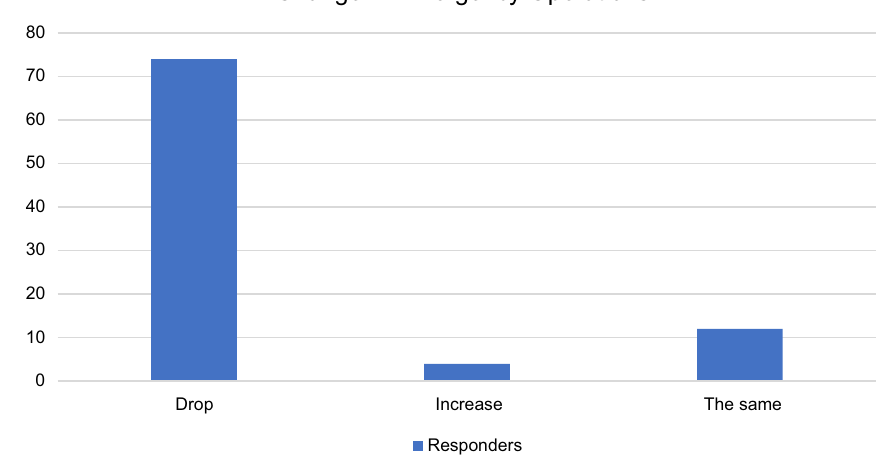
Figure 1. Effect of COVID-19 on the rate of emergency spine cases.